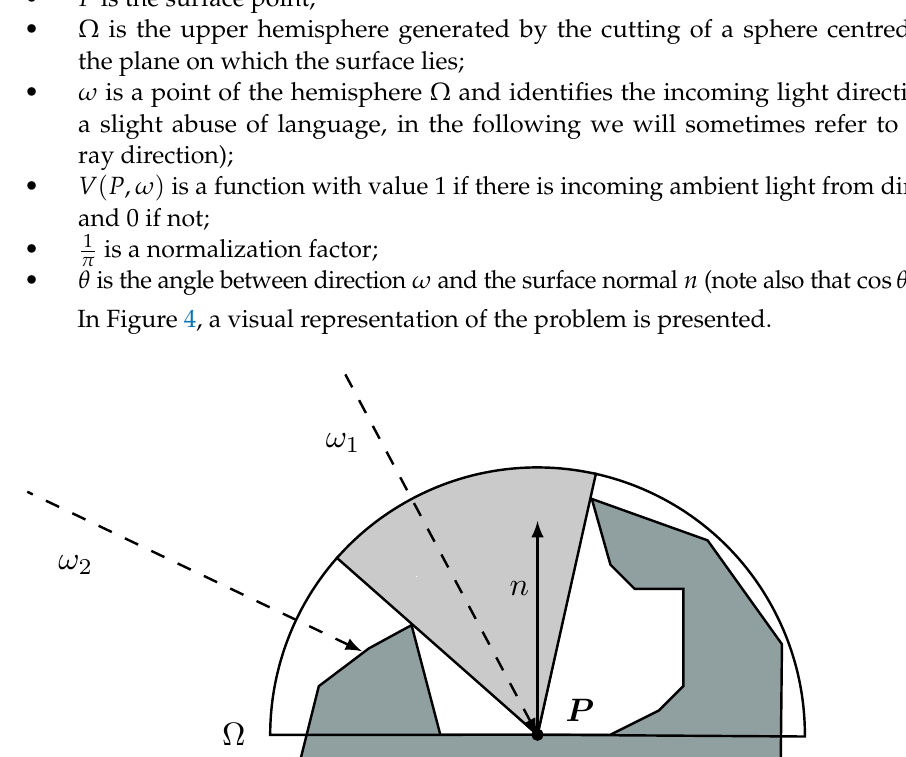
ω i in the grey ∀